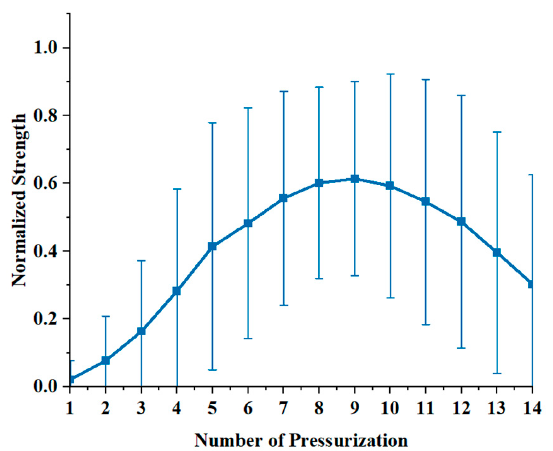
Figure 7. Number of pressurizations–normalized strength